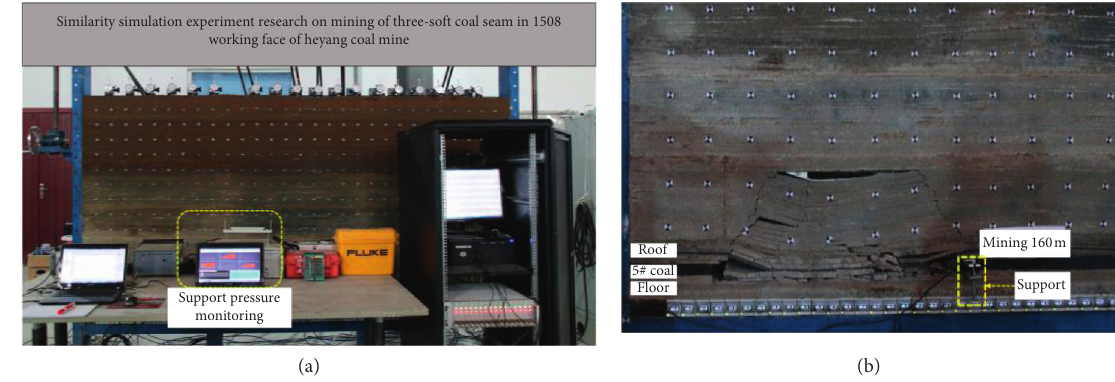
Figure 5: Similar simulation experiment of three-soft coal seam mining. (a) Overall real shot map. (b) Local real shot map.